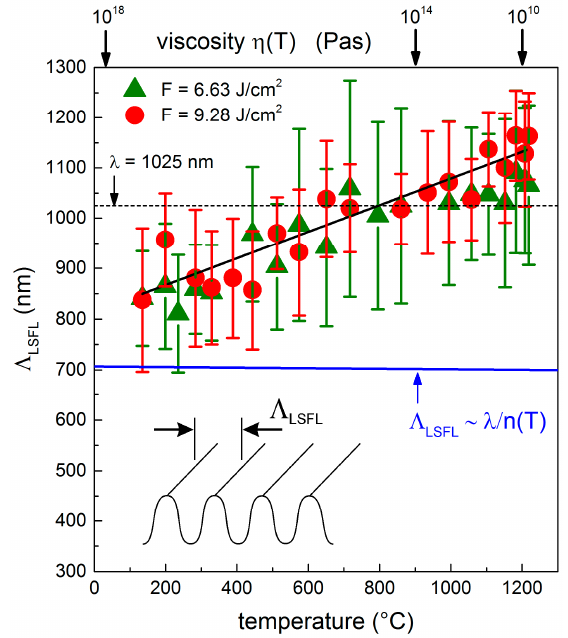
Figure 6. Spatial period, Λ LSFL , of the LSFL ( N = 5) as a function of the initial substrate temperature, T S . The vertical bars indicate the width of distribution of the corresponding 2D-FT operation and the black solid line guides the eye. The blue line corresponds to the spatial periods, Λ LSFL , predicted by the Sipe theory considering a temperature-dependent refractive index, n .